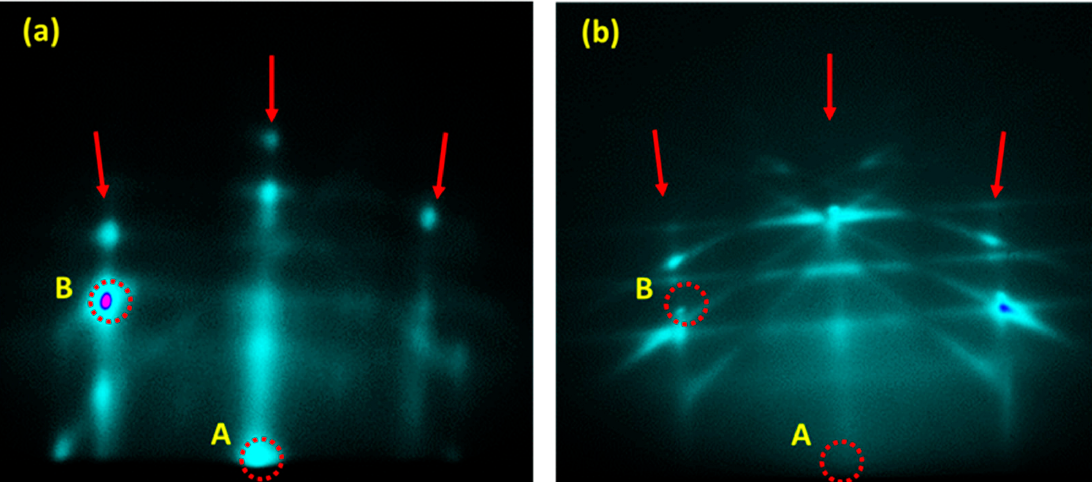
Figure 3. RHEED pattern of ( a ) the NH-117 samples after depositing 0.6 ML of Si atop the Al (111)- 1 × 1 layer. The intensity of spot A is diminished. ( b ) NH-121 samples after forming the Al layer on the hydrogenated Si surface. Clear streaks and Kikuchi lines originated from a flat epitaxial Al (111)- 1 × 1 surface are observed. In this case, no intensities are observed for spots A and B.